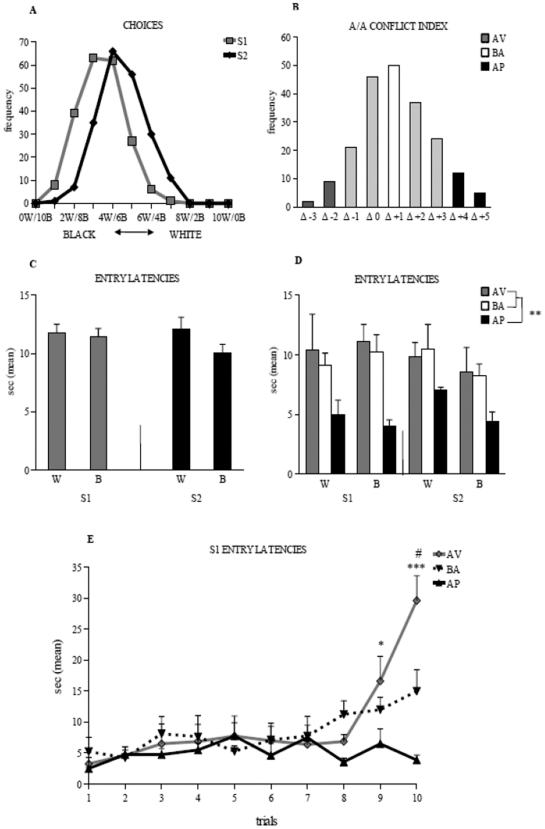
Responses to conflicting stimuli of adolescent mice in A/A Y-Maze.(A) Curves of distribution of the white and black choices of 206 animals during the sessions. (B) Curve of distribution of the A/A conflict index, considered as the difference (Δ) in the number of white choices between sessions. Entry latencies in the white and black arms of the entire sample of animals (C) and of the avoiding, balancing and approaching animals (D) during sessions, as well as latencies in the ten trials of S1 (E) in the three categories of animals are depicted. Abbreviations: W: white arm; B: black arm; S1: first session; S2: second session; AV: avoiding animals; BA: balancing animals; AP: approaching animals. In C, D, E and in the following figures, data are presented as means ± SEM. Asterisks indicate the significance level of the post hoc comparisons: in (D) AP vs. AV or BA groups: ** P<0.01; in (E) AV vs. AP groups: * P<0.05, *** P<0.0005; AV vs. BA groups: # P<0.05.